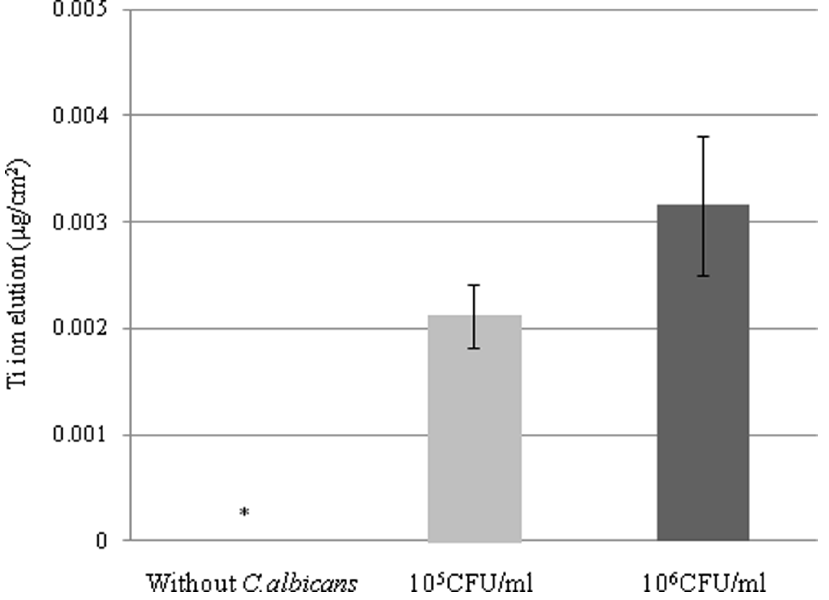
Figure 7. Ti ion elution from specimens of CP Ti immersed for 72 h in a culture in which Candidaalbicans were grown.